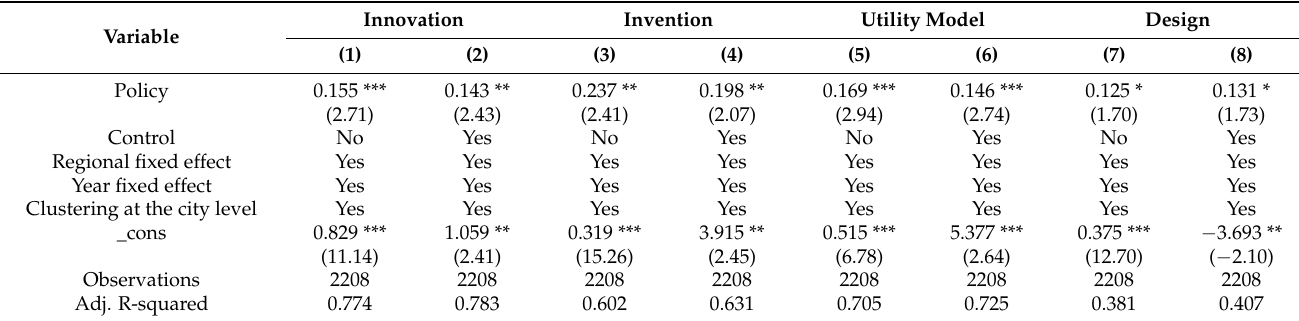
Table 10. Effects of low-carbon city construction (LCC) on technological innovation of cities. Variable Policy